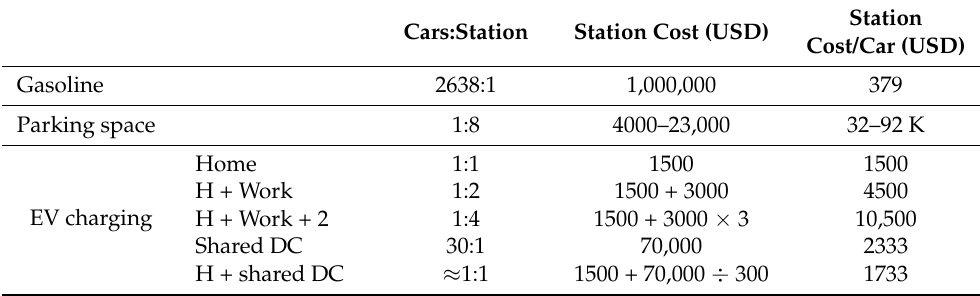
Table 1. Gasoline versus electric charging equipment in the U.S., compared with parking spaces. Each has a count and approximate cost. EV station costs are calculated for differing combinations of charging stations, corresponding to the charging-location analysis in this article (calculations in